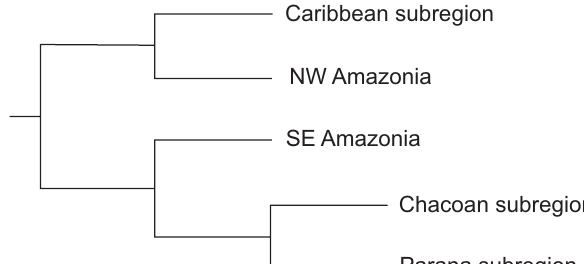
Figure 16. Relationships between areas in the Neotropical region found by N IHEI & C ARVALHO